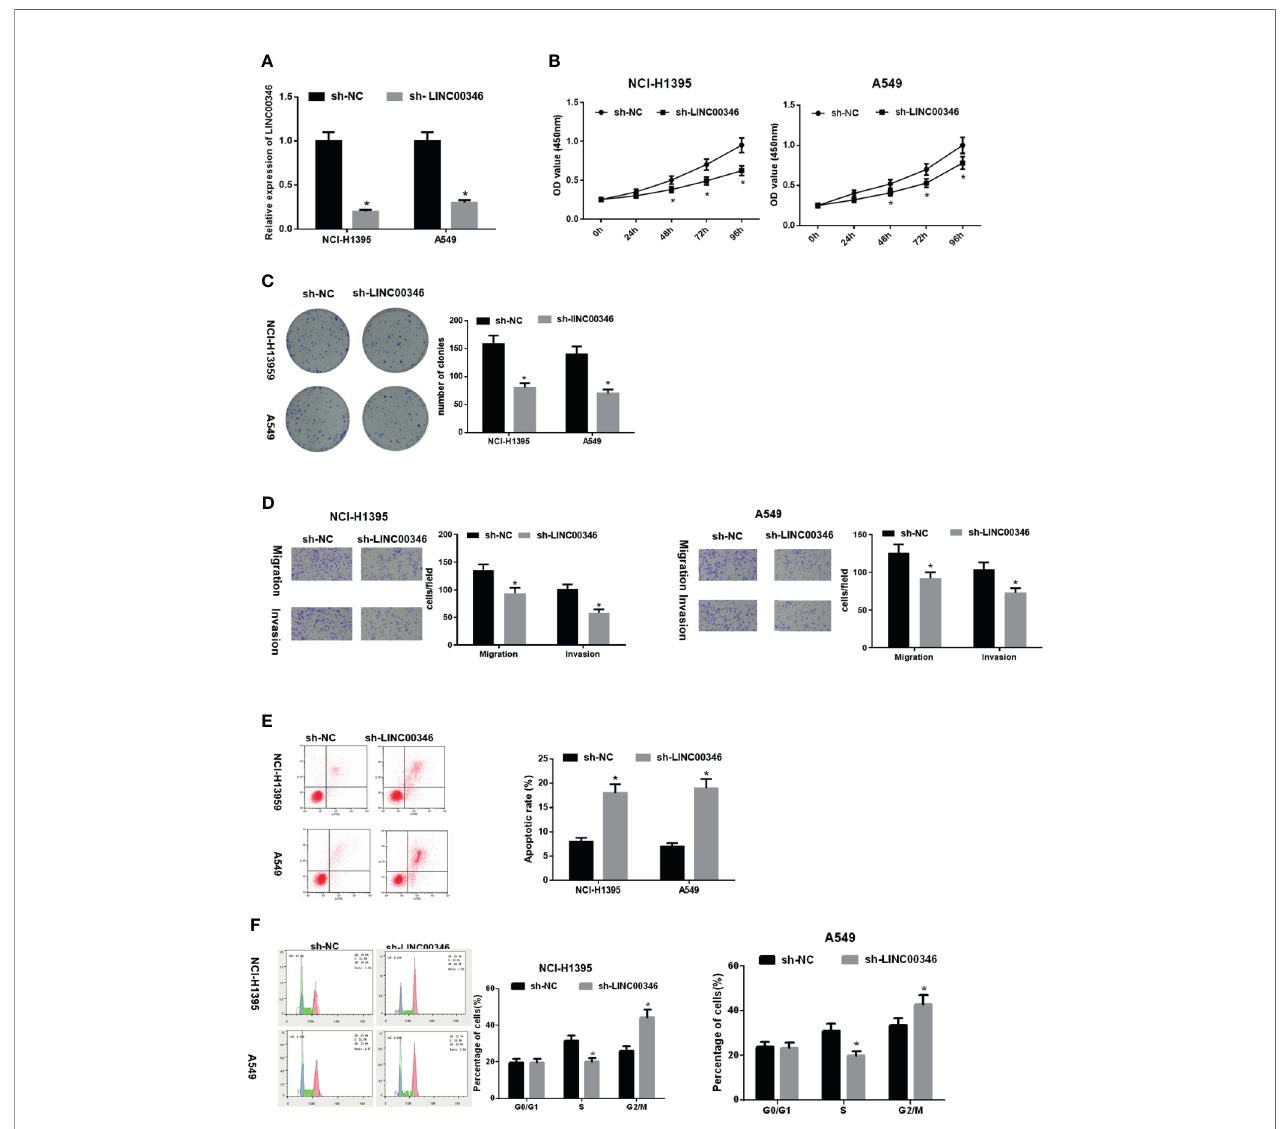
FIGURE 2 | LINC00346 inhibits the proliferation, migration and invasion of LUAD cells and promotes apoptosis. After transfecting sh-LINC00346 into LUAD cells, (A) the expression of LINC00346 in NCI-H1395 and A549 cells, (B) LUAD cell proliferation, (C) colony formation ability, (D) migration and invasion, (E) apoptosis and (F) cell cycle distribution were detected by qRT-PCR, CCK-8, colony formation, Transwell and FCM, respectively. * P <